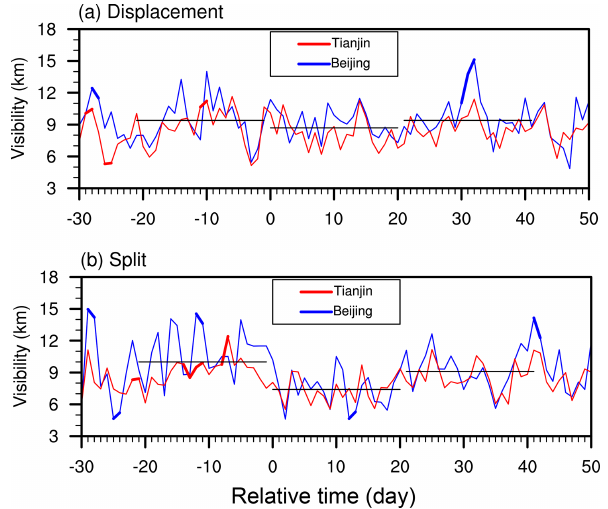
Figure 6. Composite evolution of the minimum visibility in Bei- jing and Tianjin during (a) polar vortex displacement SSW events and (b) polar vortex split SSW events. The blue curve denotes the time series of the minimum visibility in Beijing, while the red curve denotes that in Tianjin. The thickened curves denote that the com- posite is significant at the 90% confidence level using the two-sided Student’s t